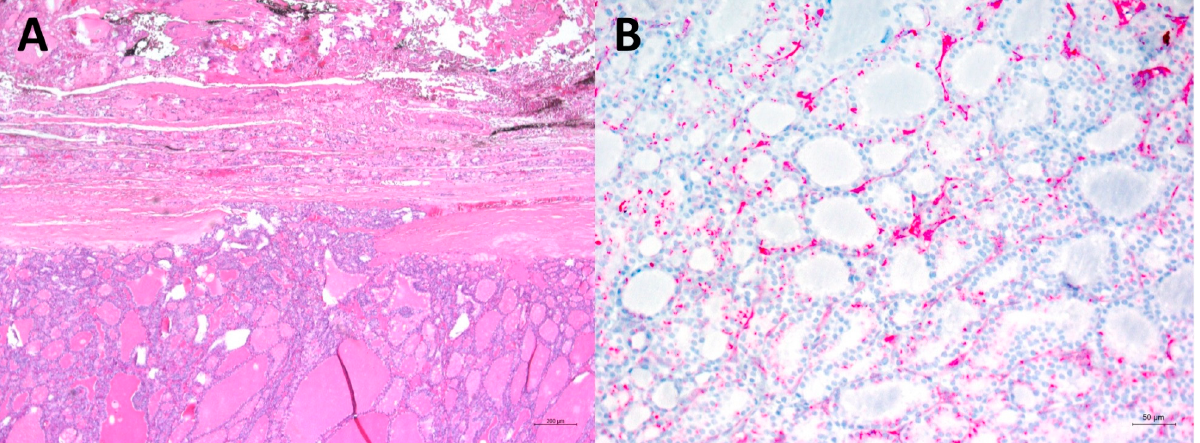
Figure 2. Histopathologic images showing minimally invasive follicular thyroid carcinoma. ( A ) Limited capsular penetration by the follicular neoplasia; hematoxilin–eosin (H&E) stain, magnification 50×. ( B ) Immunohistochemical analysis for PSMA: endothelial cells showed strong positivity in several small interfollicular vessels, magnification 200×.